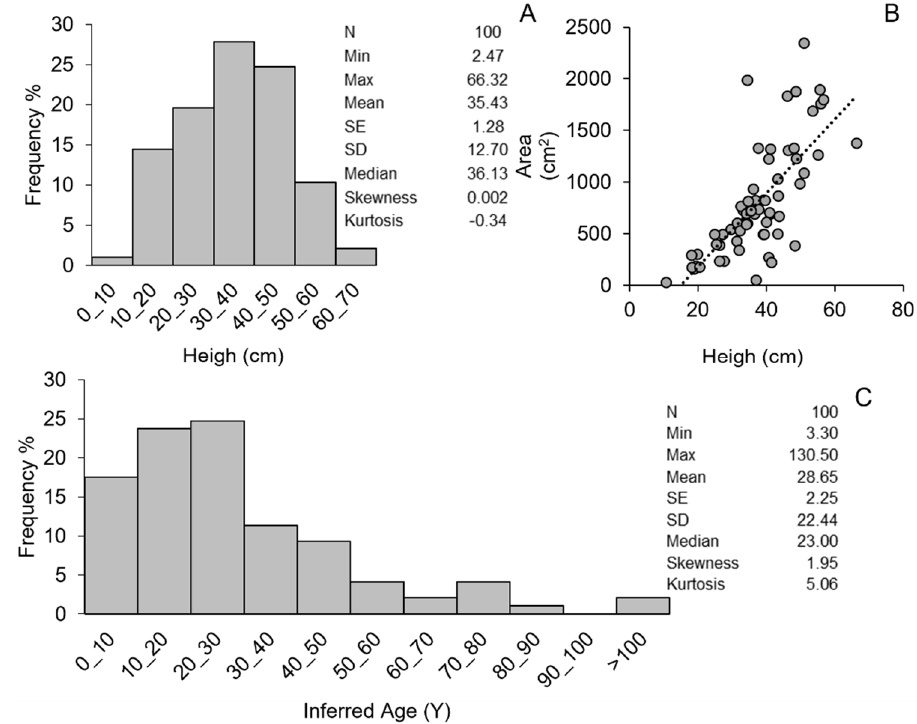
Figure 3. Morphometric description of Eunicella verrucosa colonies at the Tavolara MPA. ( A ) size– frequency distribution of the colony heights; ( B ) correlation between height and fan area; ( C ) age– frequency distribution, inferred from height of colonies according to [39].